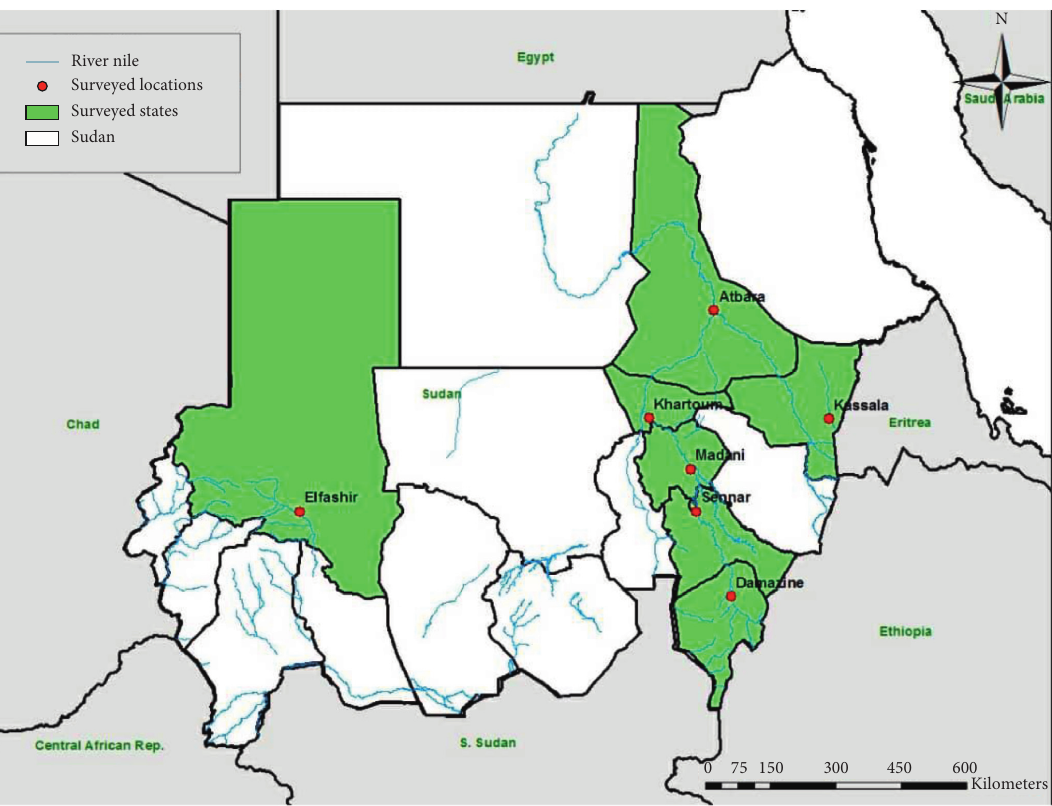
Figure 1: Map of Sudan showing states (green) and locations (red) where samples were Table 1: Univariate analysis for the association of origin of collected samples (State) and seropositivity for Simbu serogroup viruses in cattle in seven states in Sudan during the period from May, 2015, to March, 2016.